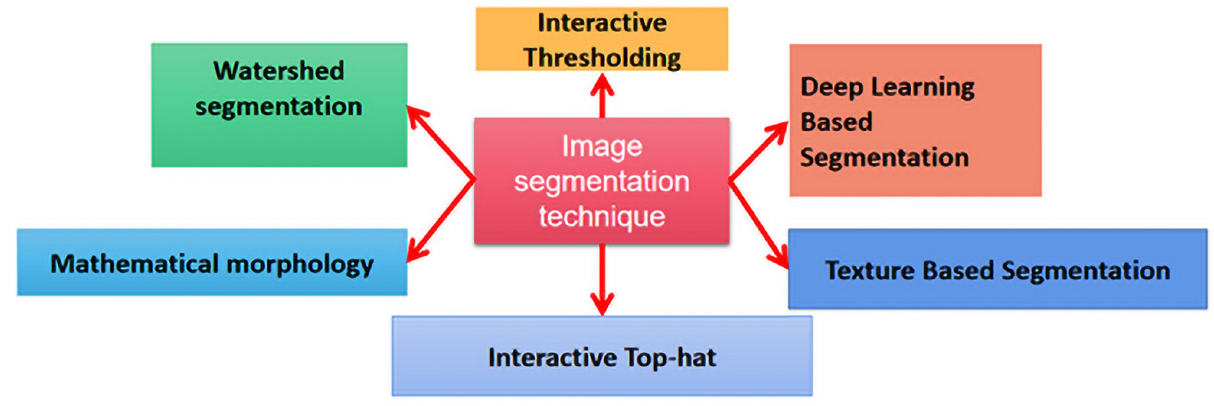
Fig 2. Image segmentation module in “Avizo”